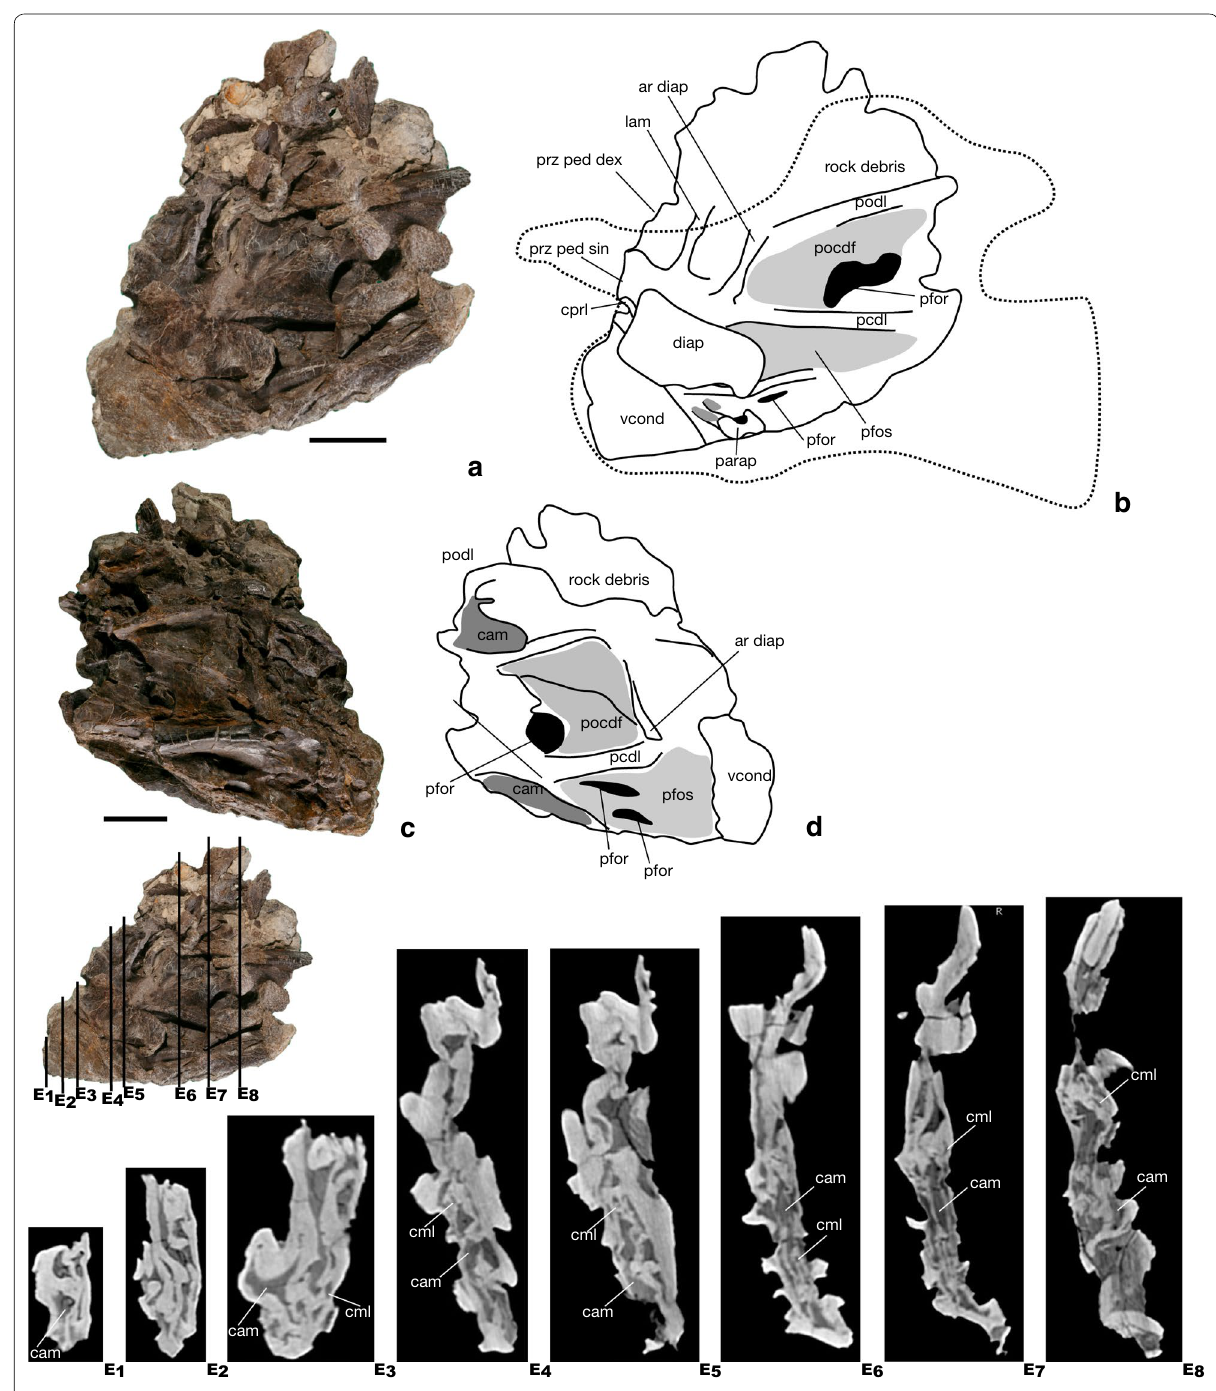
Fig. 4 Cervical vertebra NMB M.H. 265 of A. greppini . Left lateral view a as photograph and b as line drawing with indication of visible anatomical details and estimated outline of vertebra (hatched line). Right lateral view c as photograph and d as line drawing with indication of visible anatomical details. e Selected computed tomographic images of vertebra, (E1–E8) levels of transverse tomographic sections through the vertebra. Scale bar is 50 mm. ar diap area of attachment of diapophysis, cam pneumatic camera, cml pneumatic camella, cprl centroprezygapophyseal lamina, diap diapophysis, lam lamina, parap parapophysis, pcdl posterior centrodiapophyseal lamina, pfor pneumatic foramen, pfos pneumatic fossa, pocdf postzygapophyseal centrodiapophyseal fossa, podl postzygodiapophyseal lamina, prz ped dext right prezygapophyseal pedestal, prz ped sin left prezygapophyseal pedestal, vcond vertebral